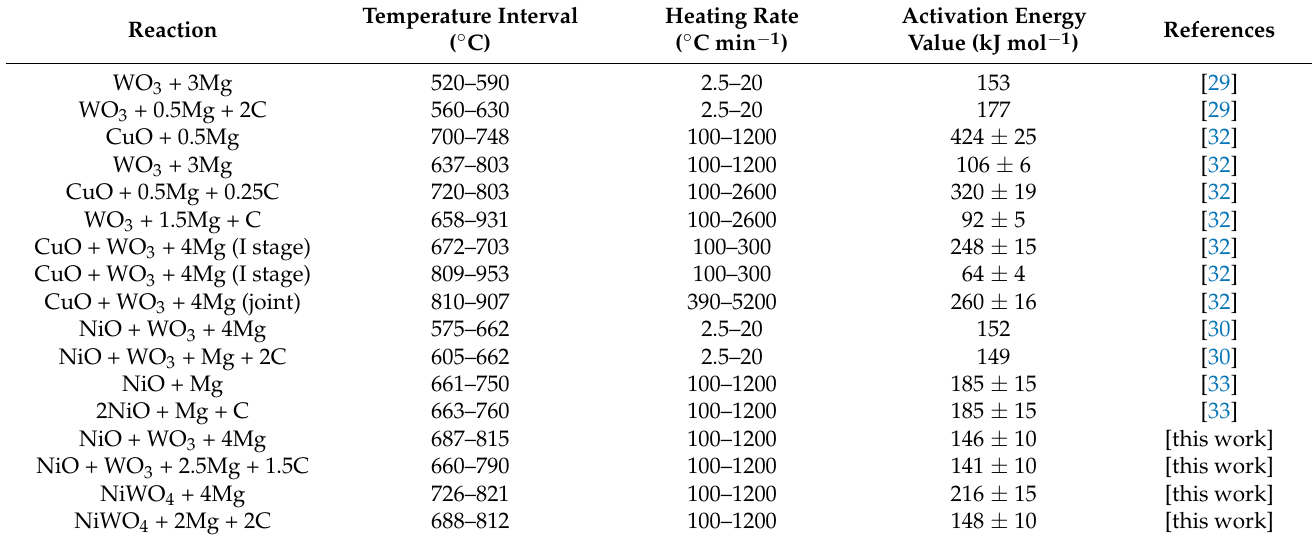
Figure 7. Linear fitting of the − ln( β (1/ T* ) 2 )–1/ T* · 10 3 plots to extract effective activation energy of the reactions in the NiO + WO 3 + 4Mg (1), NiO + WO 3 + 2.5Mg + 1.5C (2) ( a ) and NiWO 4 + 4Mg (3), NiWO 4 + 2Mg + 2C (4) ( b ) mixtures. Table 1. Comparison of the activation energy values with reference data calculated by Kissinger method.